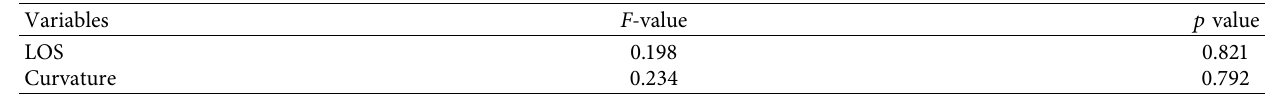
Table 6: Significance of road traffic measures on takeover time.